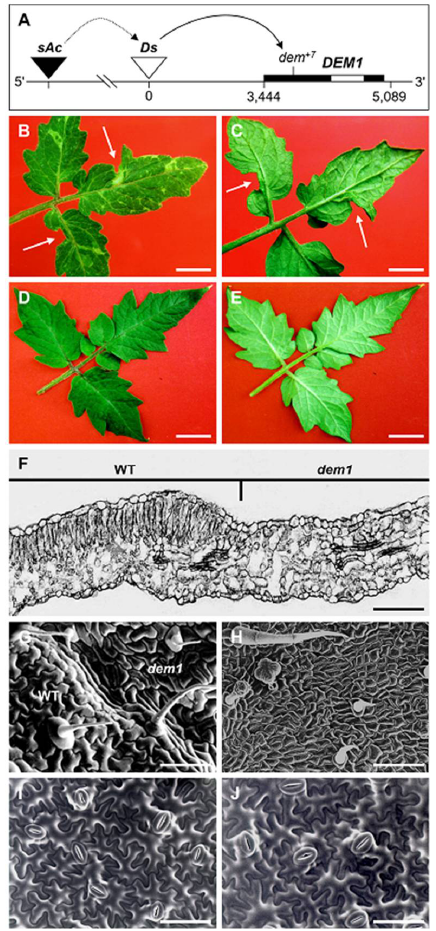
Figure 2. Leaf phenotypes displayed by mature WT tomato plants and the SMD transformant line. ( A ) Schematic of the somatic mutagenesis of the DEM1 locus in the SMD transformant line. The stabilized Ac ( sAc ; black triangle) produces the transposase which excites Ds (white triangle) for its transposition. In the SMD transformant line, the 7 bp frameshift insertion into the DEM1 reading frame ( dem +7 ) on one heterologous copy of chromosome 4 facilitates the somatic mutagenesis of DEM1 upon Ds transposition into the DEM1 gene on the second heterologous copy of chromosome 4. ( B ) The adaxial surface of SMD leaves show pale green somatic sectors, whereas the abaxial surface of SMD leaves ( C ) are phenotypically normal. The white arrows ( B , C ) indicate sectors of SMD leaves where lateral leaf blade expansion has prematurely terminated. The adaxial ( D ) and abaxial ( E ) surface of leaves of mature WT tomato plants. ( F ) Transverse section through the variegated region (a WT/ dem1 mutant sector boundary) of a mature SMD leaf which shows that palisade mesophyll fail to form beneath the cells of the adaxial epidermis in dem1 mutant sectors. ( G ) SEM of the epidermal cells of the adaxial surface of a mature SMD leaf across a WT/ dem1 mutant sector boundary. ( H ) SEM of the adaxial surface of a pale green dem1 mutant leaf sector showing the irregular size and shape of the epidermal cells and the formation of globular trichomes. SEM showing the normal development of the abaxial surface of WT ( I ) and dem1 mutant ( J ) sectors of a leaf sampled from the SMD transformant line. Scale bars = 2.0 cm ( B – E ), 100 µ m ( F – H ), and 50 µ m ( I , J ). Considering that the pale green colored sectors on the adaxial surface of SMD leaves was the most frequently observed phenotypic consequence of the somatic mutagenesis of the SlDEM1 locus (Figure 2B), we next employed a semi-nested PCR approach together with the Southern blot hybridization technique to demonstrate that in each dem1 mutant sector of a SMD leaf, the SlDEM1 coding sequence harbored a mutation resulting from Ds transposition. To achieve this goal, a series of DNA oligonucleotide primers